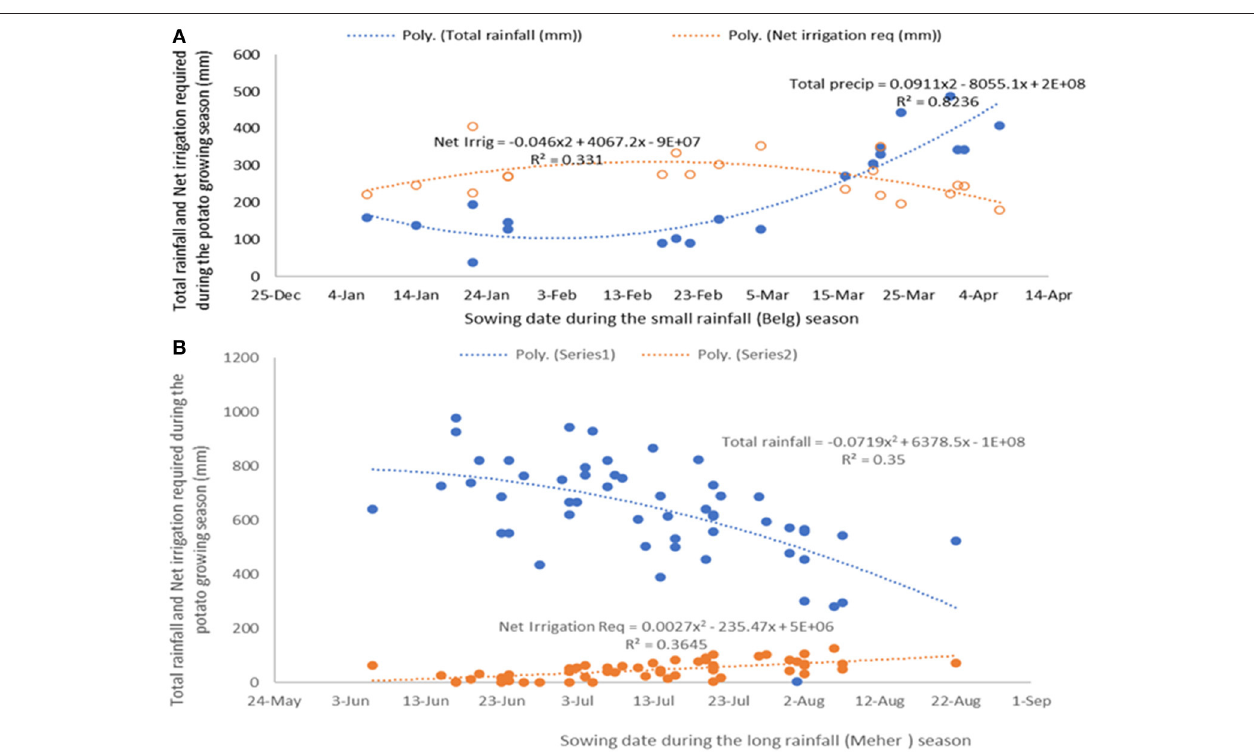
FIGURE 5 | Total precipitation during the potato growing period and net irrigation requirements as affected by time of sowing (onset) for both the Belg (A) and Meher (B) seasons at Barneb 2 irrigation scheme in Northeastern Ethiopia. Simulations were made based on daily climate data of 20 years